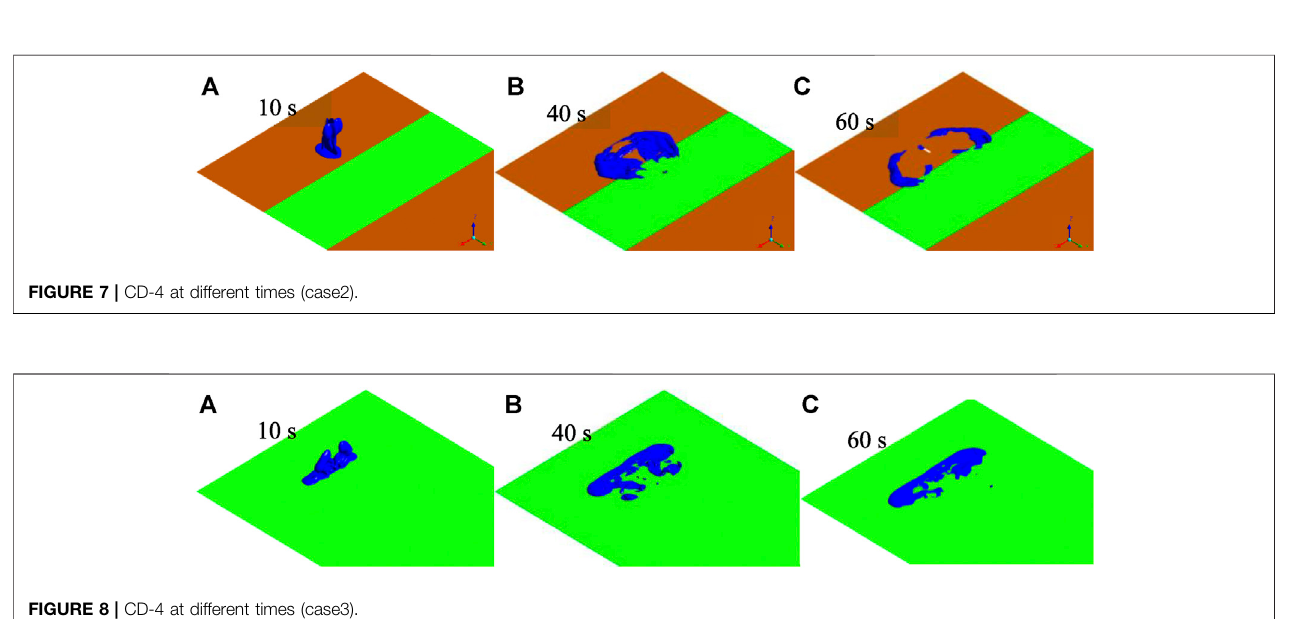
FIGURE 6 | CD-4 at different times (case1).